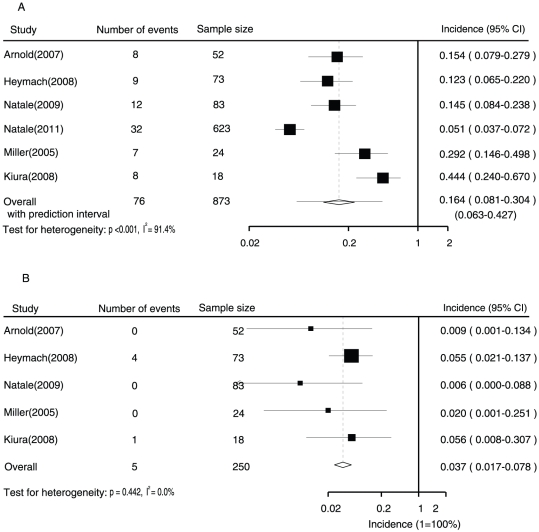
Forest plot for meta-analysis of incidence of all grade (A) and high-grade (B) prolonged QTc interval in patients with non-thyroid cancer who were assigned vandetanib.